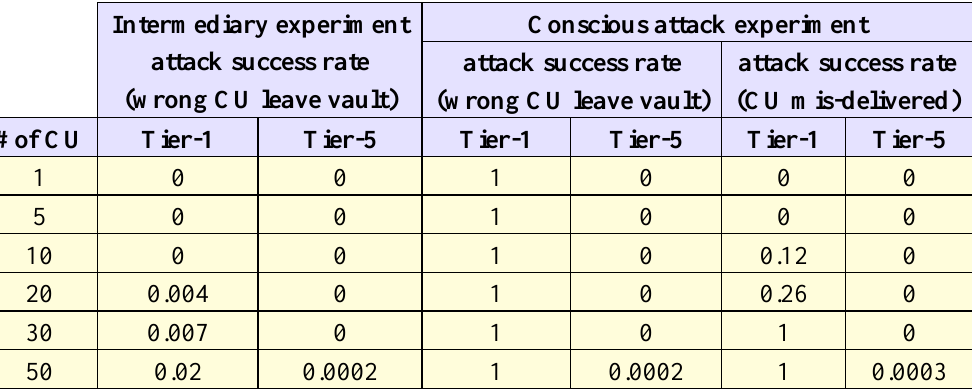
Table 4. Results for the attack